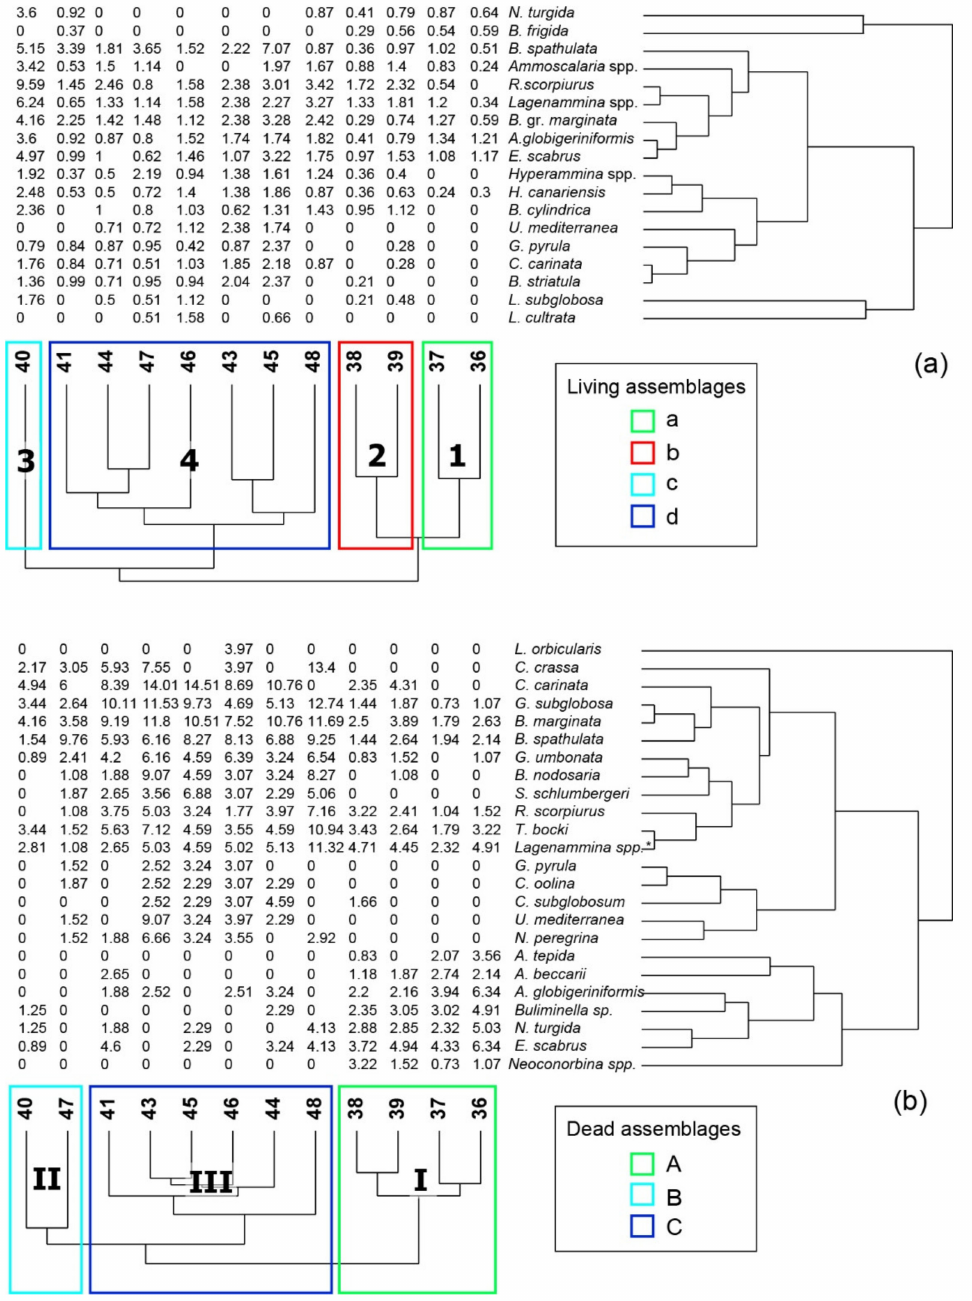
Figure 4. Two-way hierarchical cluster analysis applied on living ( a ) and dead ( b ) commonly occurring species (>5%) in the Gulf of Patti. The number of clusters and the corresponding assemblage ID are also